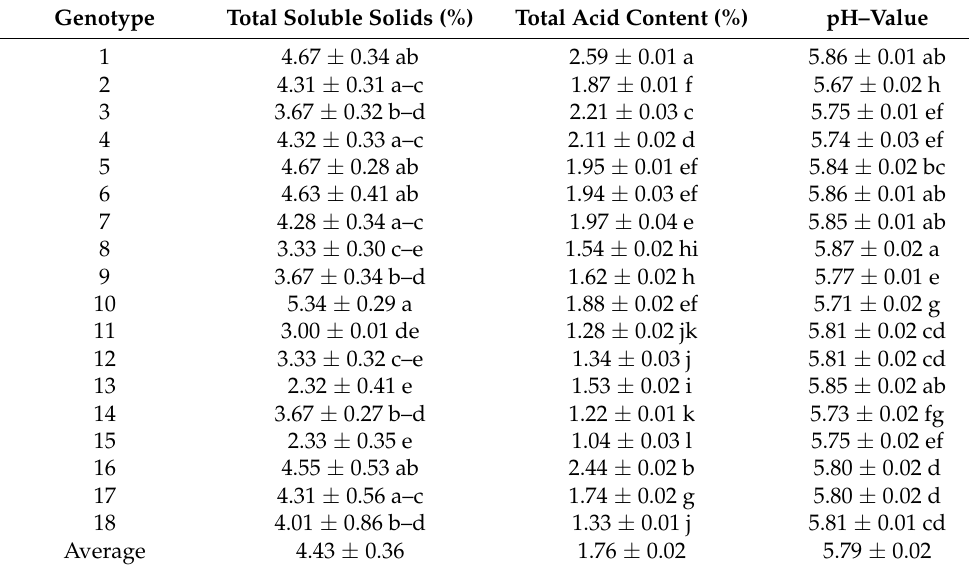
Table 2. Total soluble solids, total acid content, and pH of 18 parsley genotypes. Genotype Total Soluble Solids (%) Total Acid Content